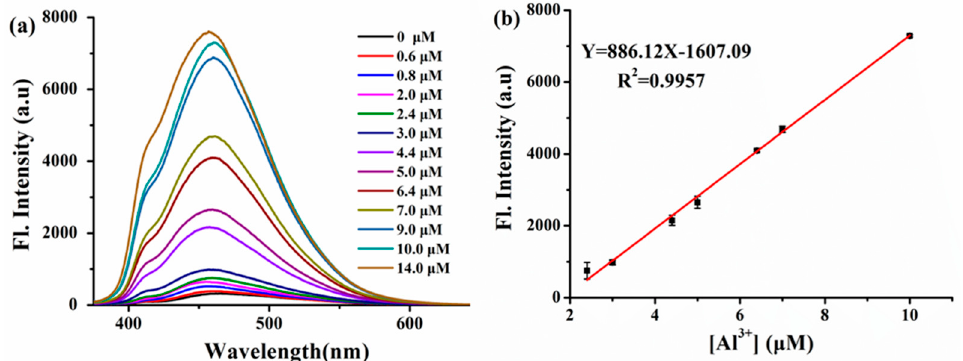
Figure 3. ( a ) Change in fluorescence spectra of ITEC (10 μM) after adding Al 3+ (0 μM, 0.6 μM, 0.8 μM,